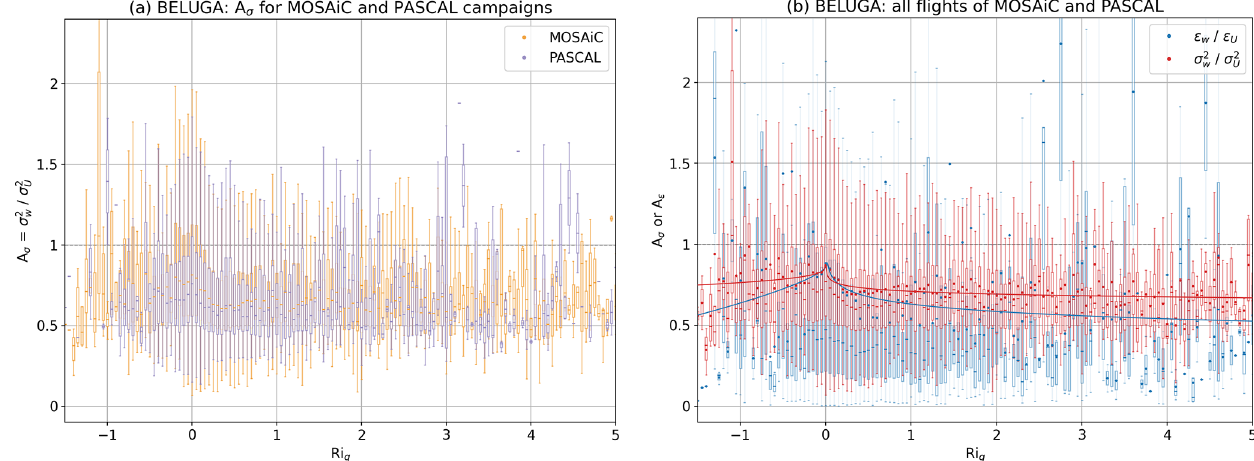
Figure 8. Anisotropy in relation to stability (expressed by Ri g ) from BELUGA measurements for the MOSAiC and PASCAL campaigns: (a) comparison of anisotropy for variances segregated between MOSAiC and PASCAL data and (b) anisotropy for variances and dissipation rates from all MOSAiC and PASCAL data. The box plots for each Ri g interval include the first quartile to the third quartile of the data, with a line at the medians and a dot at the means. The mean values are used to fit a function of the form A( Ri g ) = a ·± Ri ( 1 /c) g + b (the function is fitted to a version of the plot with a more highly resolved Ri g ).